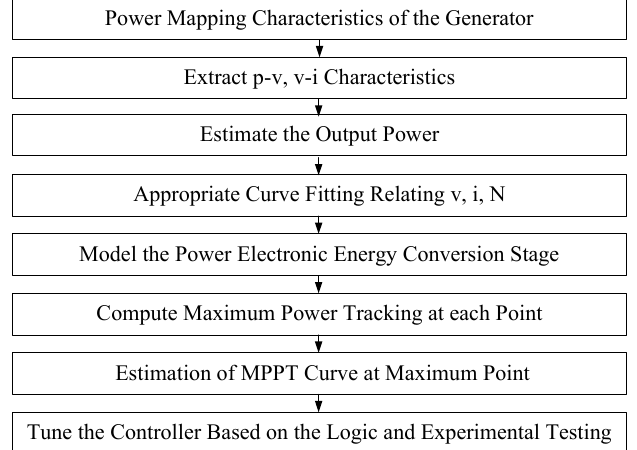
Figure 3. Flowchart of the method used for the estimator. p-v: power-voltage; v-i: voltage-current; N: speed; MPPT: maximum power point tracker.